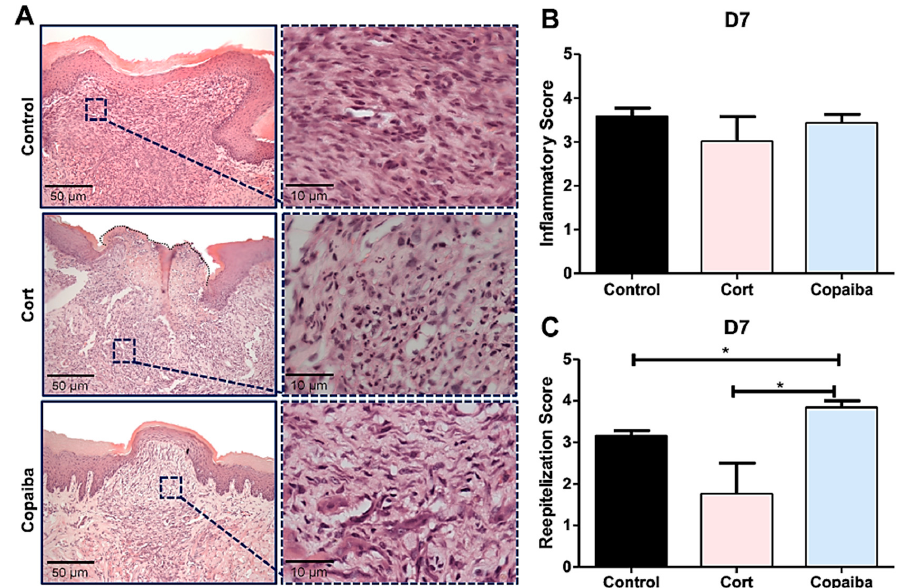
Figure 3. Histopathological analysis of treated and untreated wounds at D7. ( A ) Five- µ m sections stained by HE, showing complete closure of the wound with a uniform thickness in most of the copaiba-treated samples analyzed compared to the corticoid-treated and control samples. ( B ) Inflammatory scores presented no significant di ff erences between groups on this day. ( C ) Copaiba- treated wounds presented an advanced reepithelization stage. The corticoid-treated group still revealed a poor reepithelization performance on this day (original magnification × 200 and × 1000). One-way ANOVA and Tukey’s post hoc tests ( n = 15) (* p < 0.05). The resolution of the inflammatory stage in the connective tissue characterized by the disappearance of chronic inflammation was observed in all the groups on D7 (Figure 3a), though with some differences in collagen deposition.